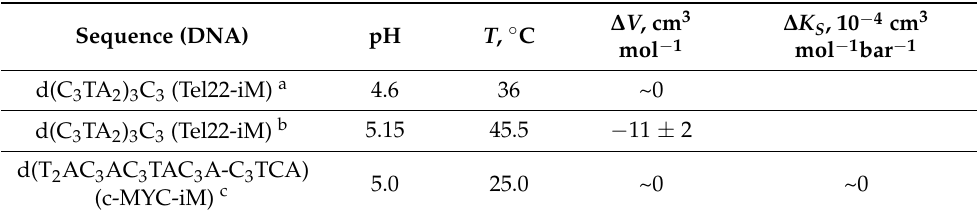
Table 5. Changes in volume, ∆ V , and adiabatic compressibility, ∆ K S , accompanying the unfolding transitions of i -motif structures determined at temperature, T.